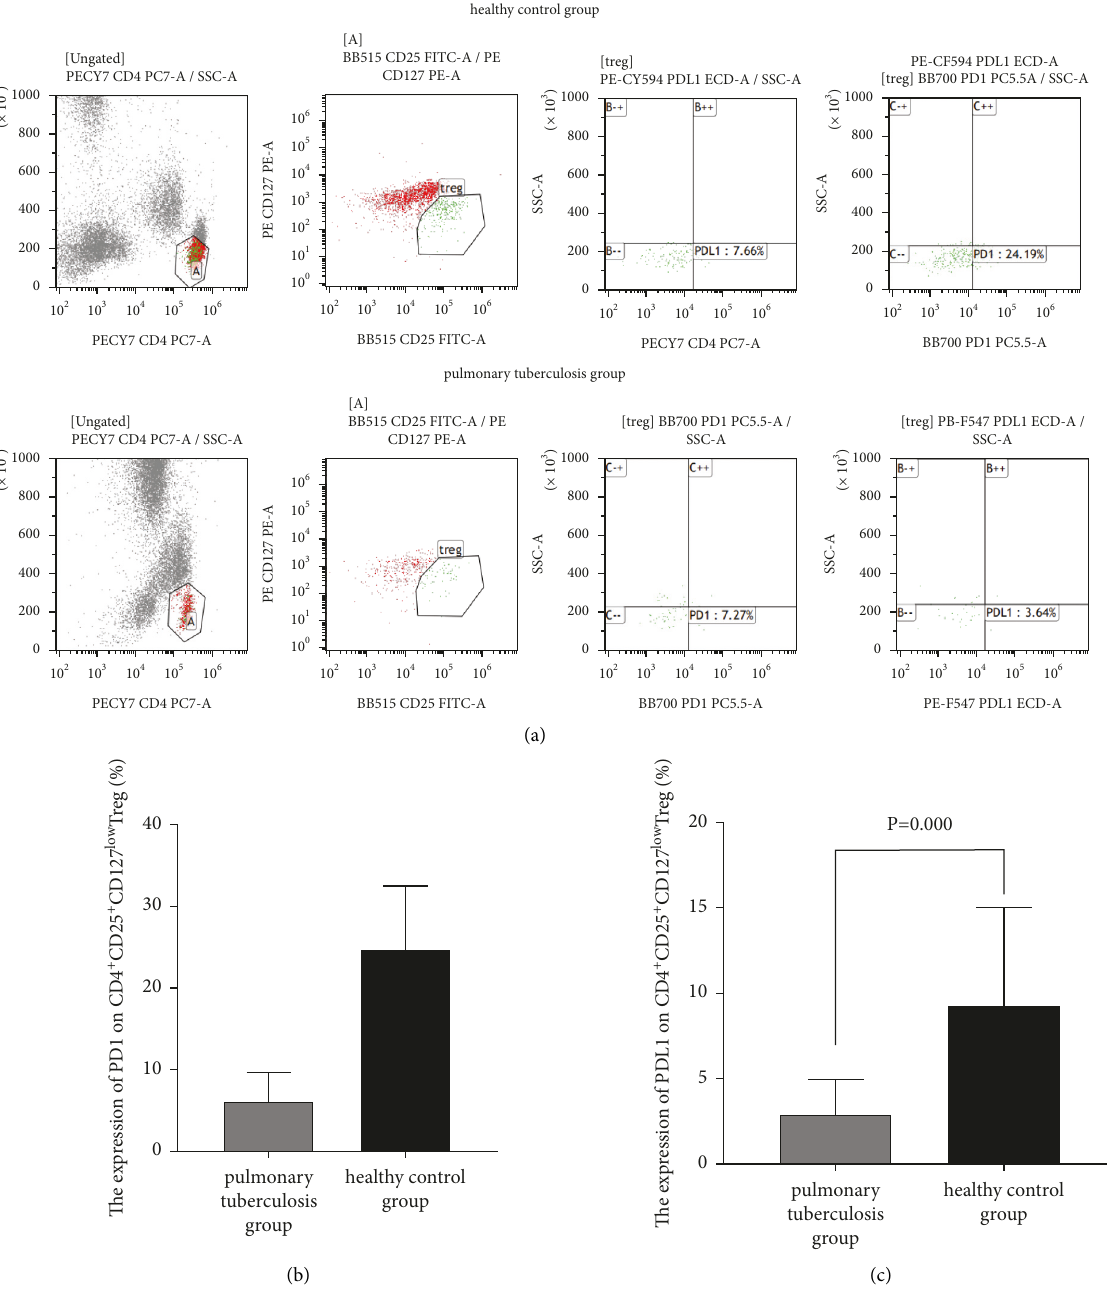
Figure 3: Flow cytometry detecting PD-1 and PD-L1 expression on peripheral blood CD4 + CD25 + CD127 low Tregs among active pulmonary tuberculosis. (a) Representative flow cytometric plots for detection of PD-1 and PD-L1 expression on peripheral blood CD4 + CD25 + CD127 low Tregs. (b) Comparison of PD-1 expression on peripheral blood CD4 + CD25 + CD127 low Tregs between active pul- monary tuberculosis patients and healthy controls. (c) Comparison of PD-1 expression on peripheral blood CD4 + CD25 + CD127 low Tregs between active pulmonary tuberculosis patients and healthy